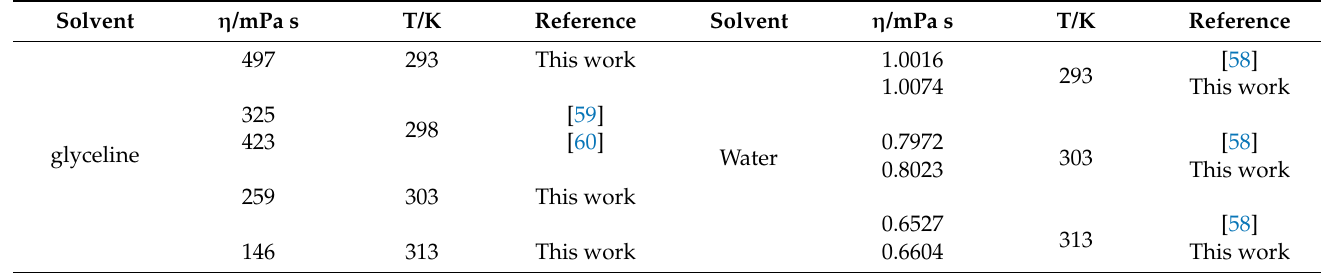
Table 3. Dynamic viscosity values for glyceline and water at different temperatures (published and obtained